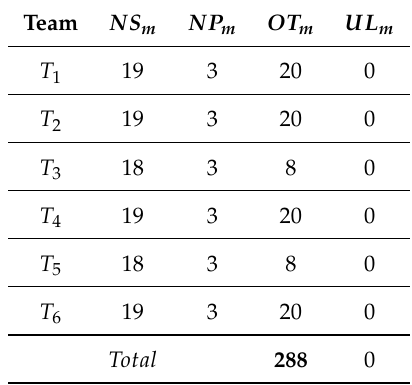
Table 6. Analysis of the optimized physician schedule for September.